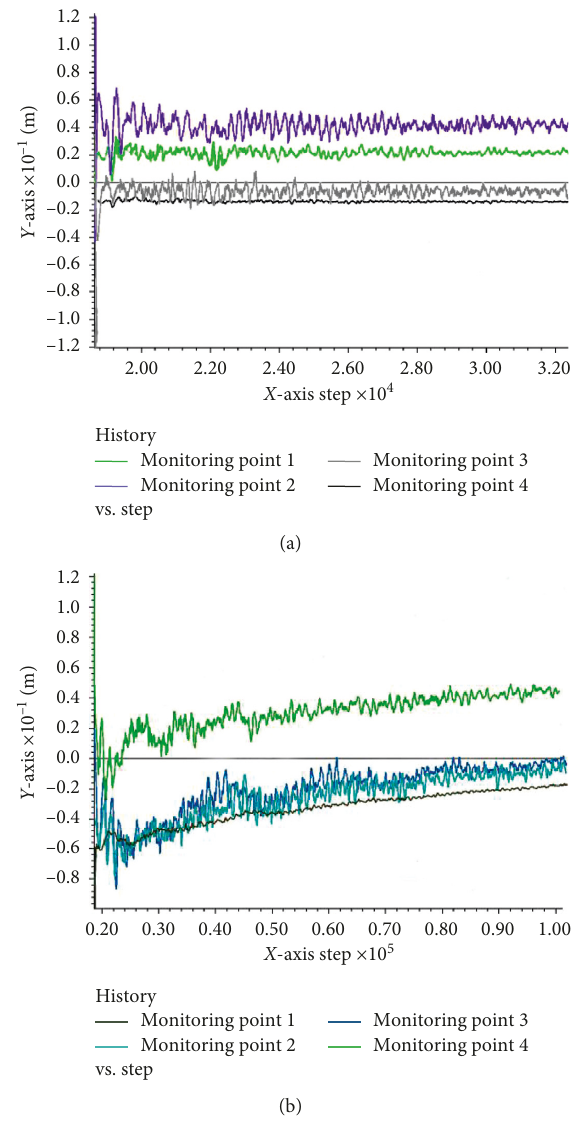
Figure 12: Displacement response diagram for one dynamic load. (a) X -direction displacement and (b) Z -direction